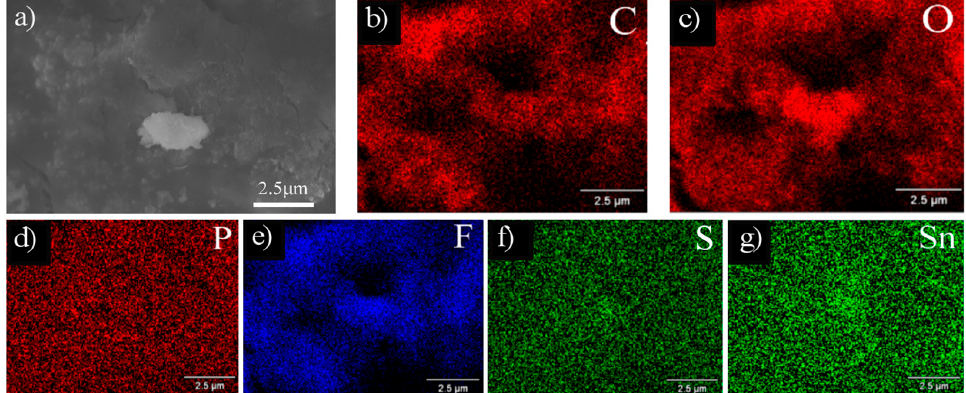
Figure 8. FESEM images of ( a ) 20SnS/AG, ( b – g ) EDS mapping of the area in ( a ). The element being mapped is indicated in each image.